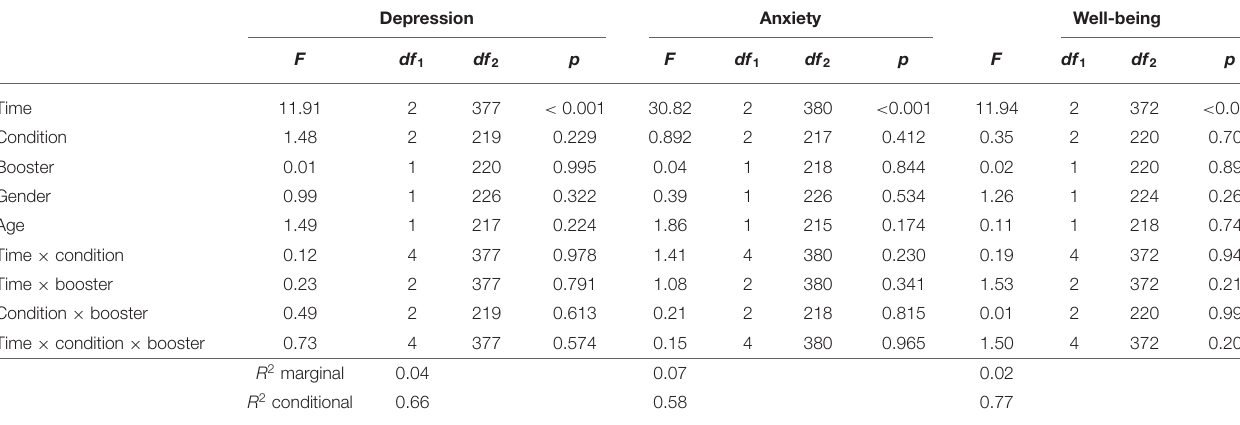
TABLE 2 | Results of the LMM analyses for primary outcomes, omnibus tests for fixed effects. Depression Anxiety